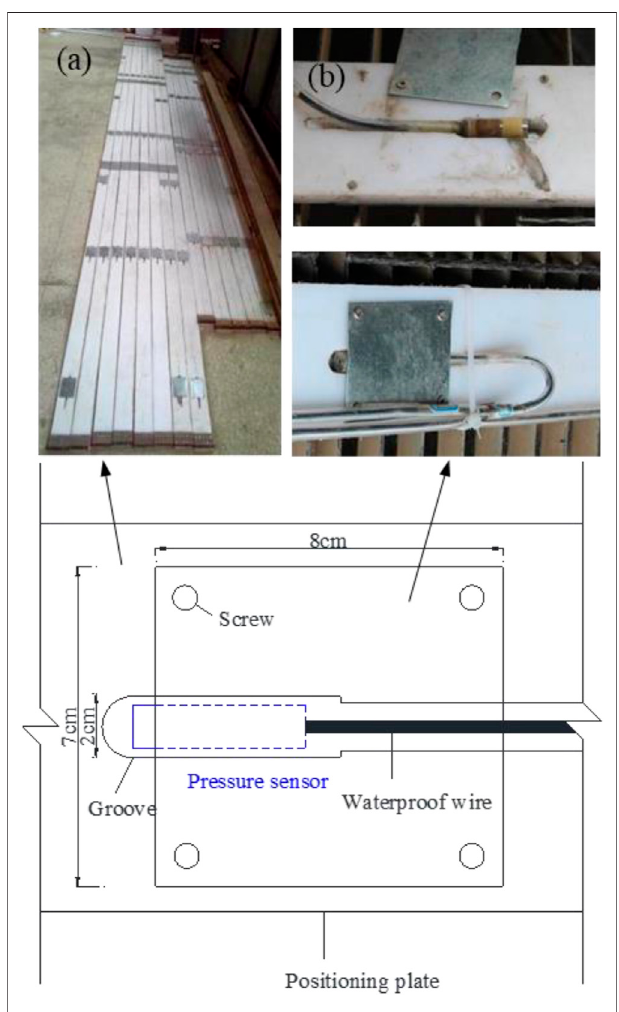
FIGURE 1 | Schematic diagram of positioning piece. (A) Positioning plate (B) Micro-sensor.